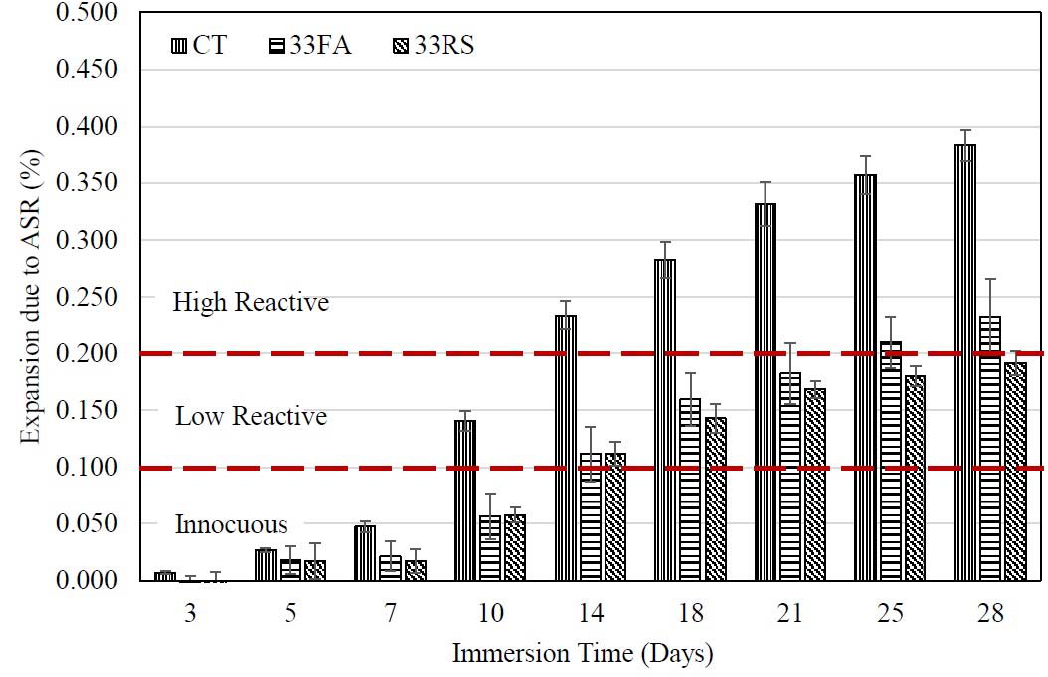
Figure 7. Relationship between the ASR expansion of 33FA and 33RS mortars and immersion time.